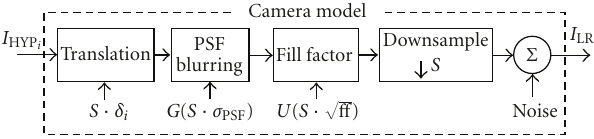
Figure 5: Camera model used in the